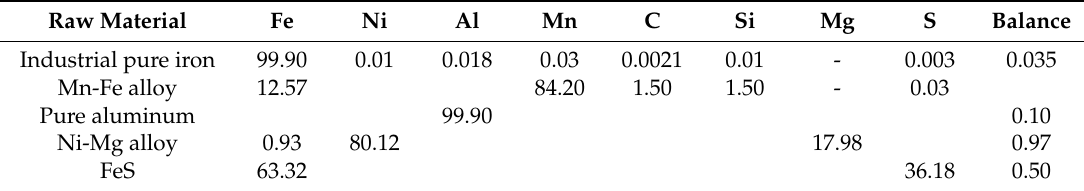
Table 1. Compositions of raw materials (mass